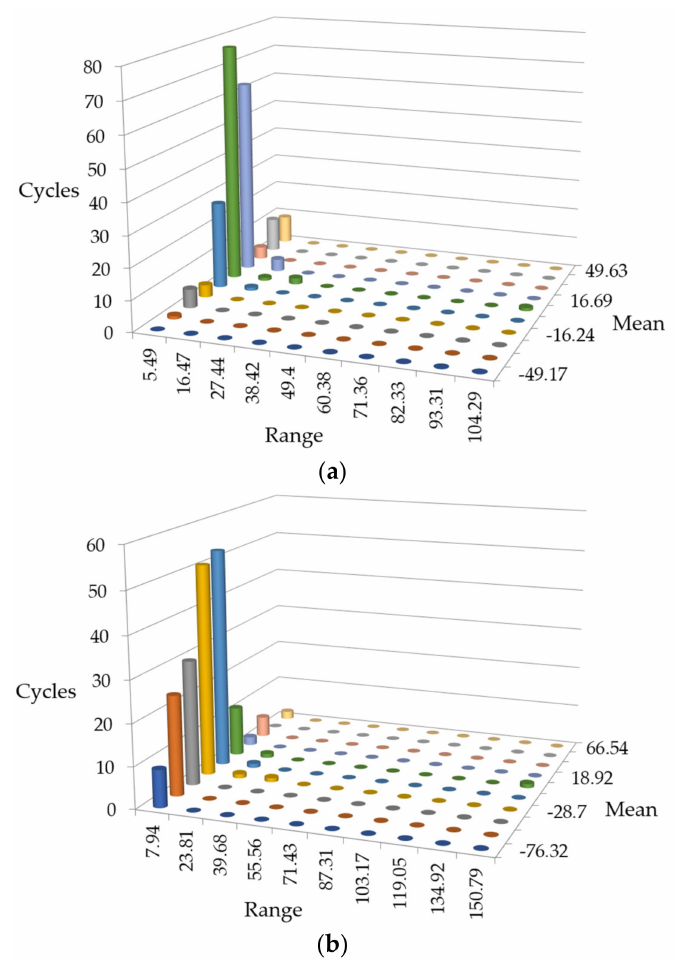
Figure 9. Rain flowing counting results: ( a ) left push arm; ( b ) right push